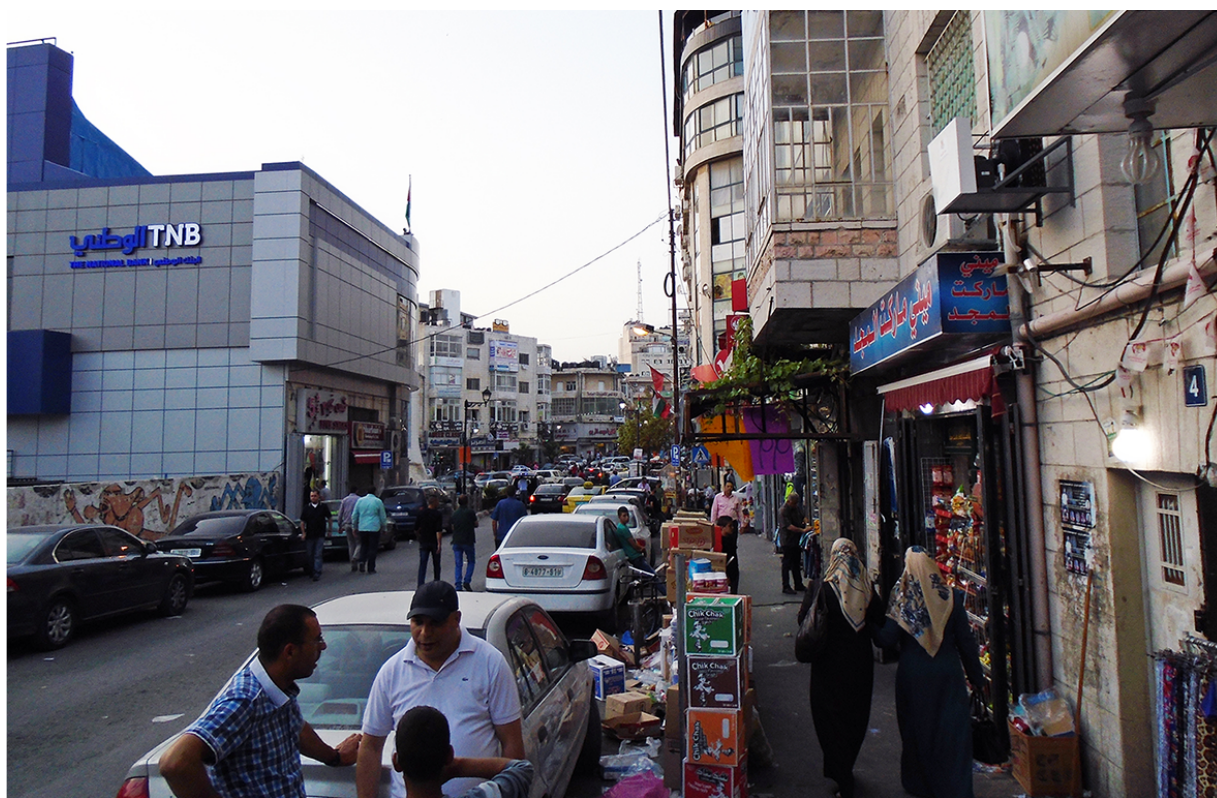
Figure 2. Area A delineates the major pre-existing Palestinian urban agglomerations, such as Ramallah, and is under full Palestinian jurisdiction and civil